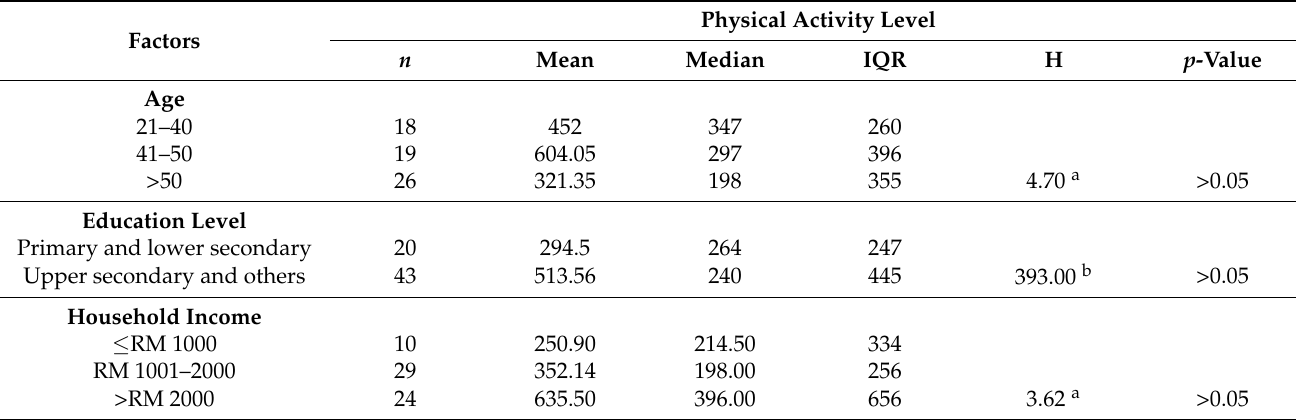
Table 6. Mean differences between physical activity level, age group, education level, and household